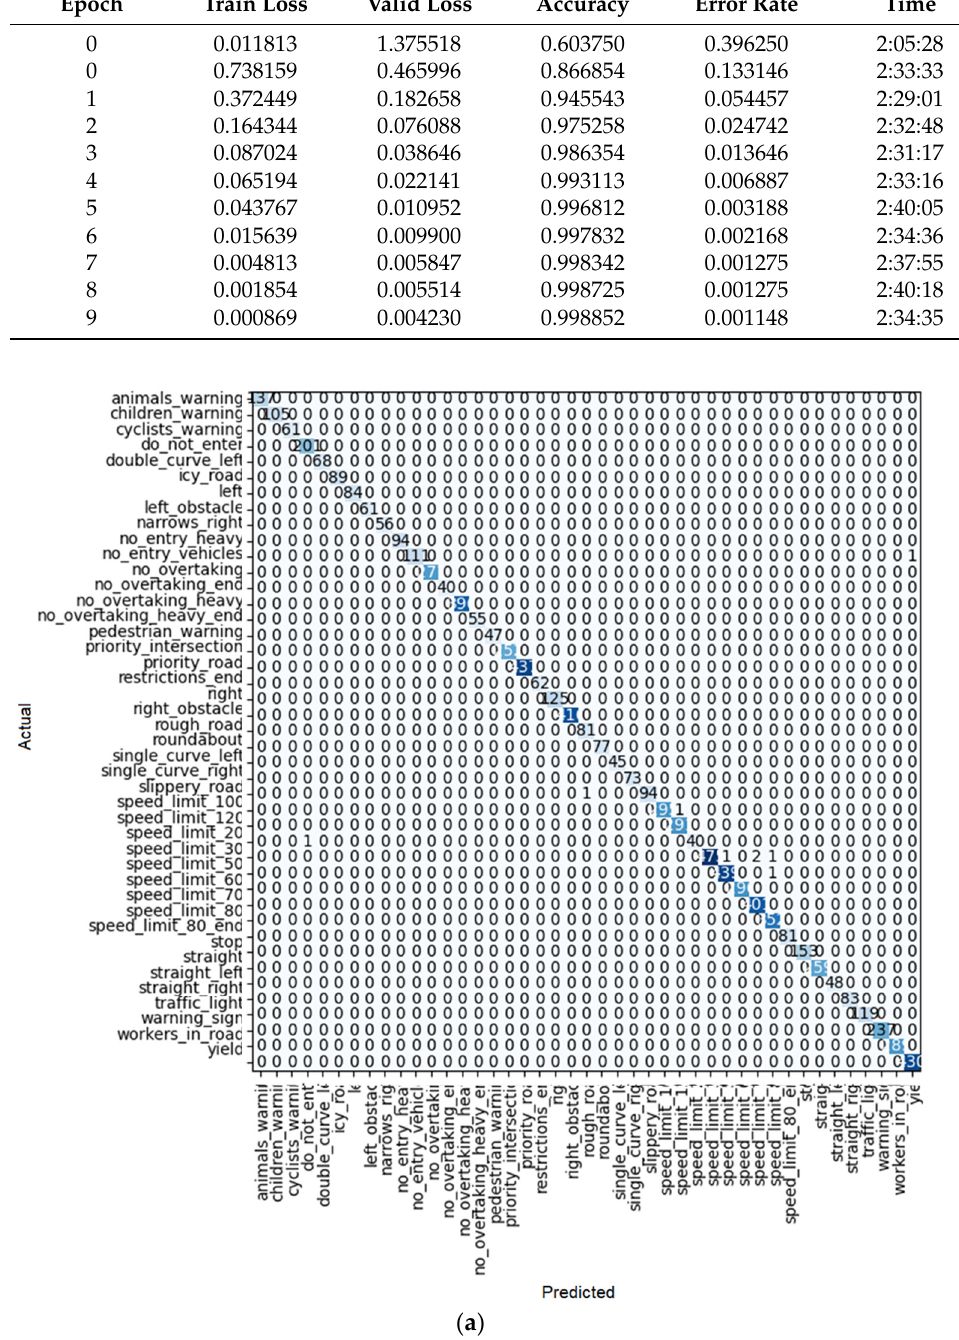
( b ) Figure 17. ( a ) Confusion matrix and ( b ) loss rate during training with XResNet5.